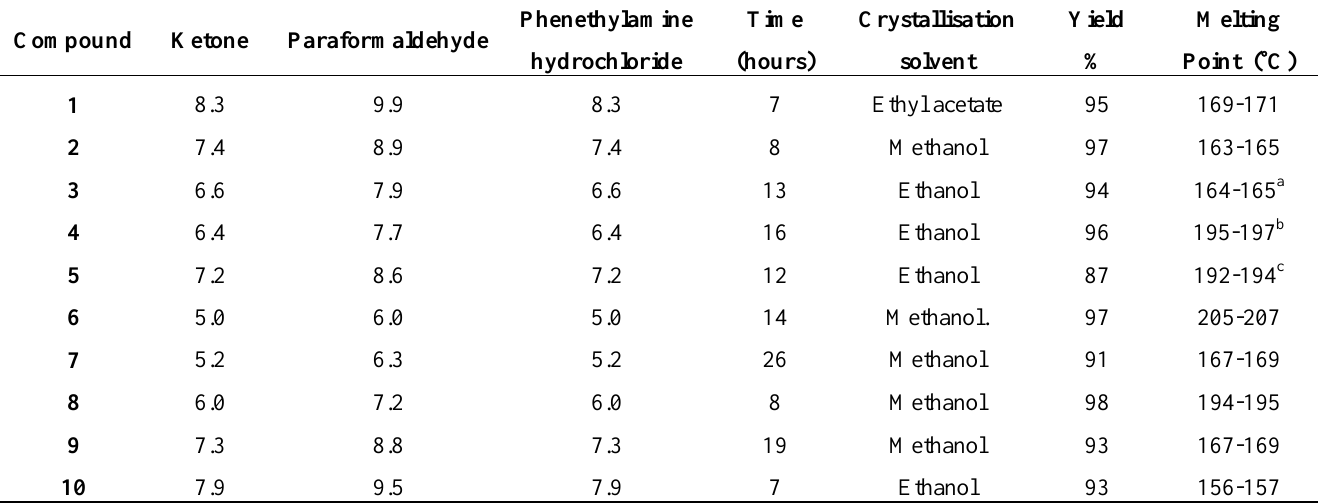
Table 4. The amounts of reagent (mmol), reflux times of the reactions (hours), crystallisation solvents, yield of the reactions (%), and the melting points of the compounds ( o C). Compound Ketone